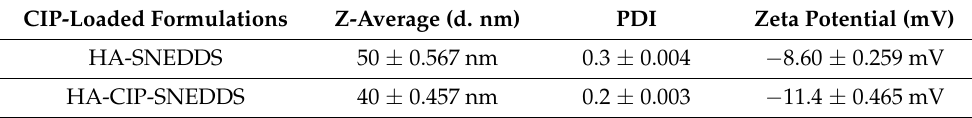
Table 3. Zeta sizing results of CIP-loaded nano-formulations. The results are listed as mean ± S.D (n =